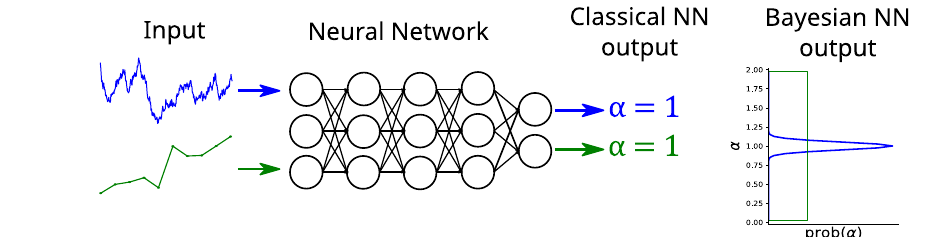
Fig.2|Illustrationoftheproblemofreliabilityindeeplearning. Theillustration depicts the use of a neural network to predict the anomalous exponent α for two sample trajectories. Despite receiving severely different inputs, a classical neural networkmaystillpredictthesameoutput(anomalousdiffusionexponent α =1)for